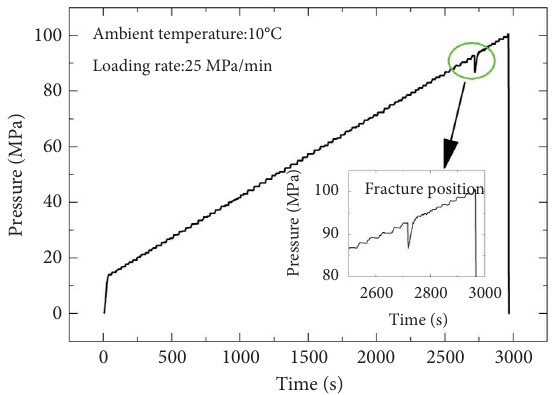
Figure 4: Ultimate strength test curve of